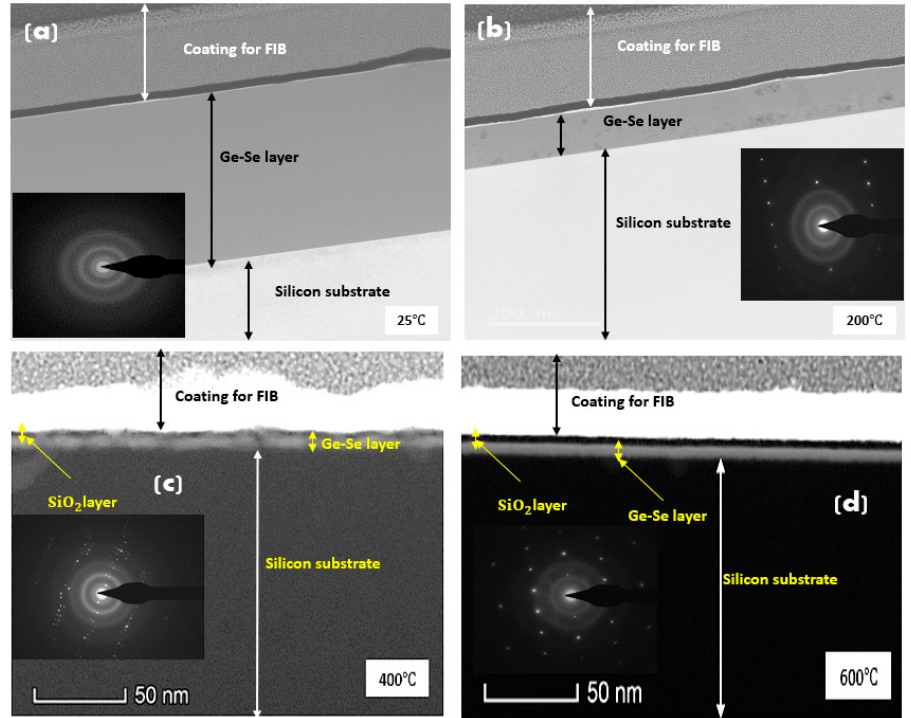
Figure 2. TEM cross-section images of Ge-Se layers formed on silicon substrates by fs-PLD at various substrate temperatures ( a ) 25 °C (S25), ( b ) 200 °C (S200), ( c ) 400 °C (S400), and ( d ) 600 °C (S600). The SAED pattern of sample S25 confirms the presence of amorphous material owing to the existence of spherical overlap rings around the central spot., while the remaining samples S200, S400, and S600 exhibit a mixture of amorphous and polycrystalline features because of interdiffusion between the silicon substrate and GeSe 4, or diffusion of the GeSe 4 into the silicon substrate. Energy-dispersive X-ray (EDX) analysis of the four TEM cross-sections of the thin films fabricated at various substrate temperatures was performed in scanning-TEM (STEM) mode on the TEM to understand the elemental distribution within the thin film layer. The elemental EDX-STEM maps of silicon (Si), germanium (Ge), selenium (Se), and oxygen (O) of the samples prepared at 25 °C and 200 °C are shown in Figure 3a,b without any intermixing of the deposited Ge-Se thin film, the silicon substrate, and the thin silica layer on it. This shows that Ge, Se, and O elements are uniformly distributed within the Ge-Se thin film. Elemental EDX-STEM maps of Ge, Se, and O from the sample prepared at 400 °C are shown in Figure 3c. The deposited Ge-Se layer exhibits slight intermixing and interdiffusion behaviour with the silicon substrate at the interface. For the 600 °C samples, as shown in Figure 3d, the EDX-STEM maps show that the deposited Ge-Se layer has no evidence of intermixing. Instead, GeSe 4 is able to diffuse into the silicon to form a thin film layer within the silicon substrate. This diffusion of GeS 4 into a silicon substrate at an elevated temperature can be described as thermally-induced and assisted by the thin silica layer present on the silicon.